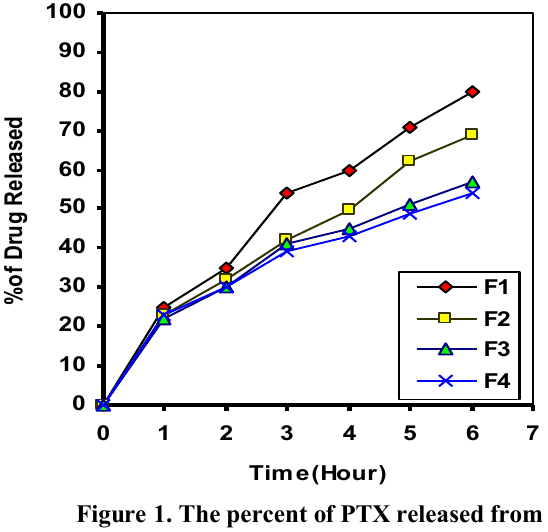
Figure 1. The percent of PTX released from different formulas at phosphate buffer pH 6.8 using Eudragit RL100 polymer.